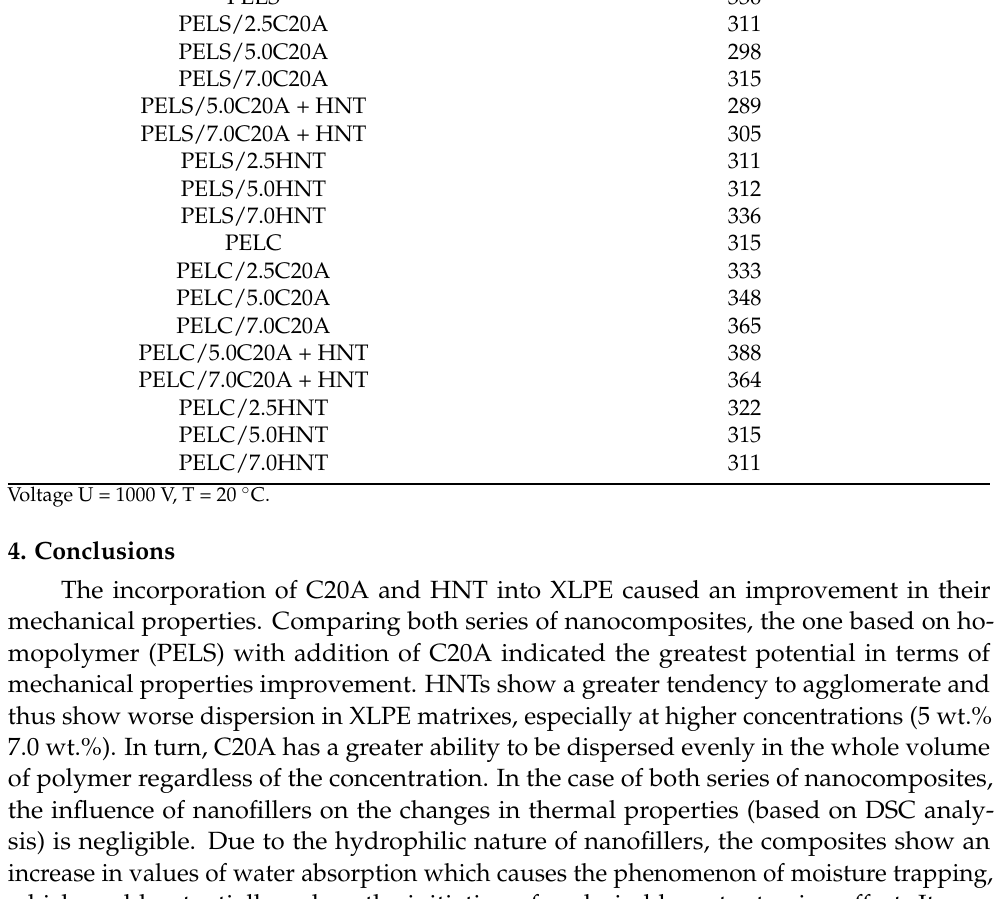
Table 6. Volume resistivity of PELS-based and PELC-based nanocomposites.